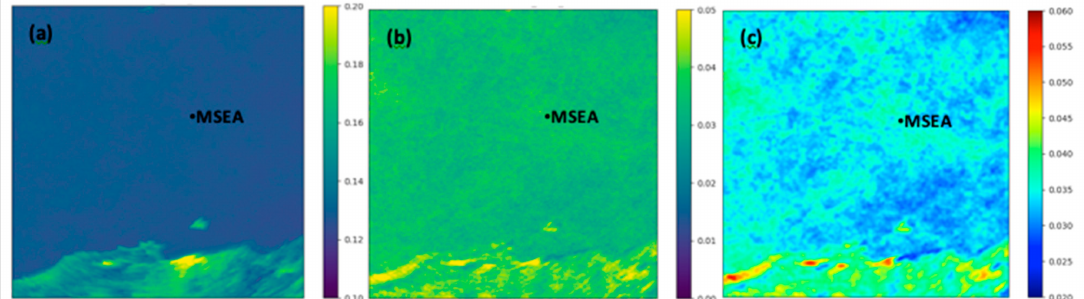
Figure 15. Spatial and temporal variability of top-of-atmosphere radiance ( L toa ) from S3A / ocean and land colour instrument (OLCI; April 2016–May 019) over the MSEA site: ( a ) median of L toa (W m − 2 sr − 1 ) for entire time series; ( b ) standard deviation (SD) of L toa time series; ( c ) combined temporal and spatial (5 pixels × 5 pixels area) SD. (Locational coordinates (same for all panels): top left corner = 24.65 ◦ E, 36.30 ◦ N; top right = 25.85 ◦ E, 36.10 ◦ N; bottom right = 25.60 ◦ E, 35.20 ◦ N; bottom left = 24.40 ◦ E, 35.40 ◦